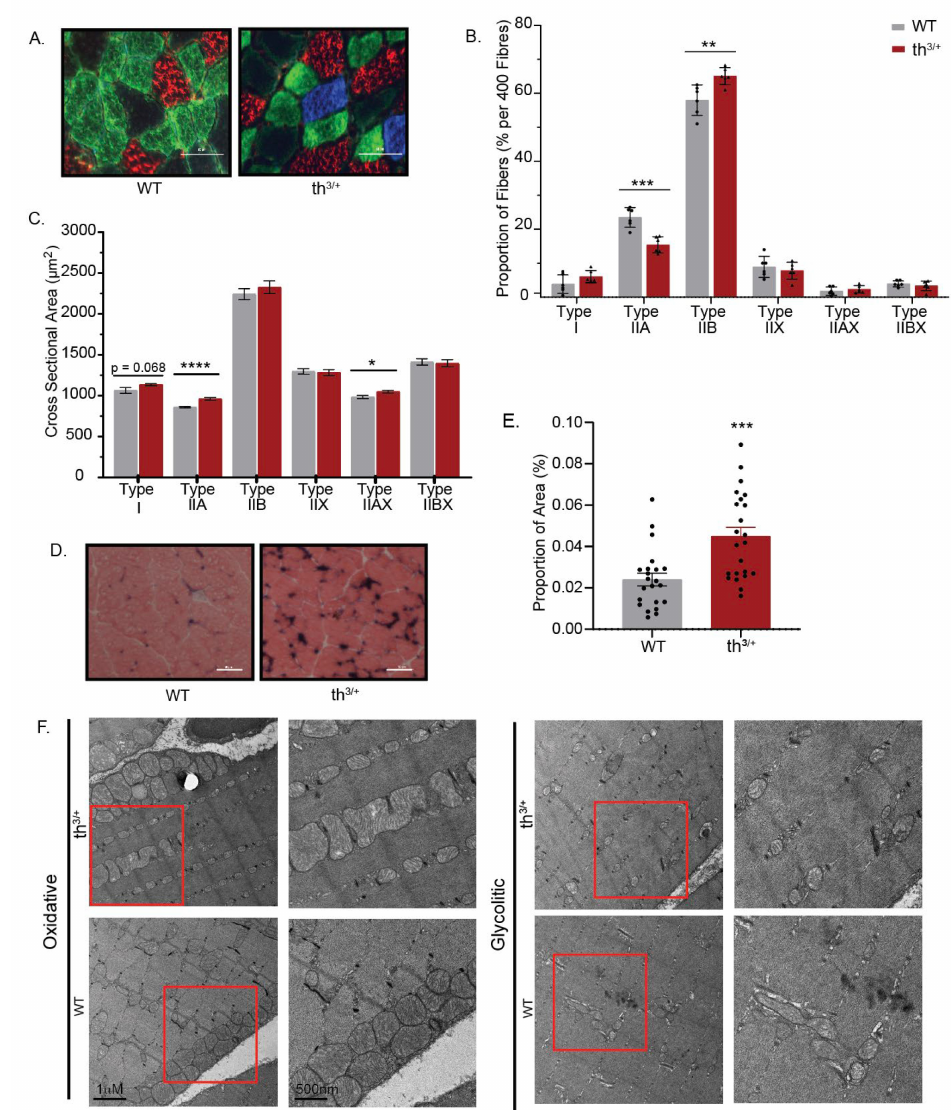
Figure 4. Partial deletion of β -globin gene results in altered phenotype in the gastrocnemius muscle. ( A ) Representative images of th 3/+ and WT gastrocnemius-fibre-type staining. each colour represents a different fiber type: blue is Type I, green is type IIA, red is Type IIB, blue is type I and black is Type IIX. The scale bar represents 60 µ m. ( B ) Immunohistochemical analysis of fibre type proportions per 400 fibres in the gastrocnemius of thalassemia (th 3/+ ) and wild-type (WT) mice (N = 4 with 100 fibres quantified per muscle). ( C ) Cross-sectional area ( µ m 2 ) of fibre types in the gastrocnemius. ( D ) Representative images of th 3/+ and WT gastrocnemius alkaline phosphatase stain. Capillaries are indicated by dark colour, with background of muscle fibers as red. The scale bar represents 50 µ m. ( E ) Percentage of alkaline phosphatase stain present in selected regions of interest in th 3/+ and WT gastrocnemius muscle. ( F ) Representative TEM images for both oxidative and glycolytic muscle samples, with a red-highlighted box shown at higher magnification on right. n = 6 in both th 3/+ and WT groups. Data in graphs are mean ± SEM. Statistical differences from independent t -test analysis (* p < 0.05, ** p < 0.01, *** p < 0.001, **** p < 0.0001) versus